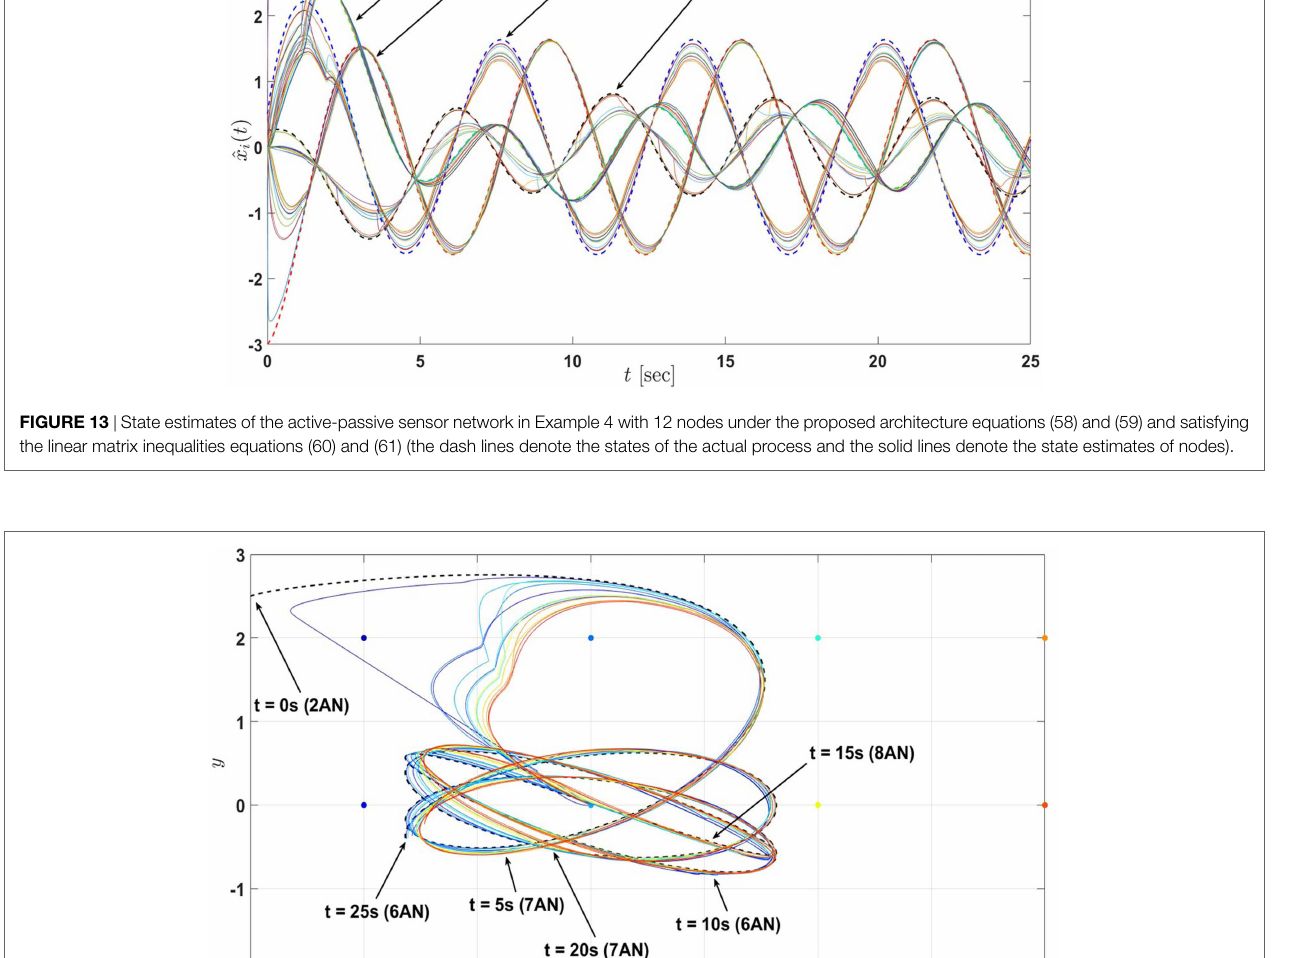
Fr ontiers in Robotics and AI |